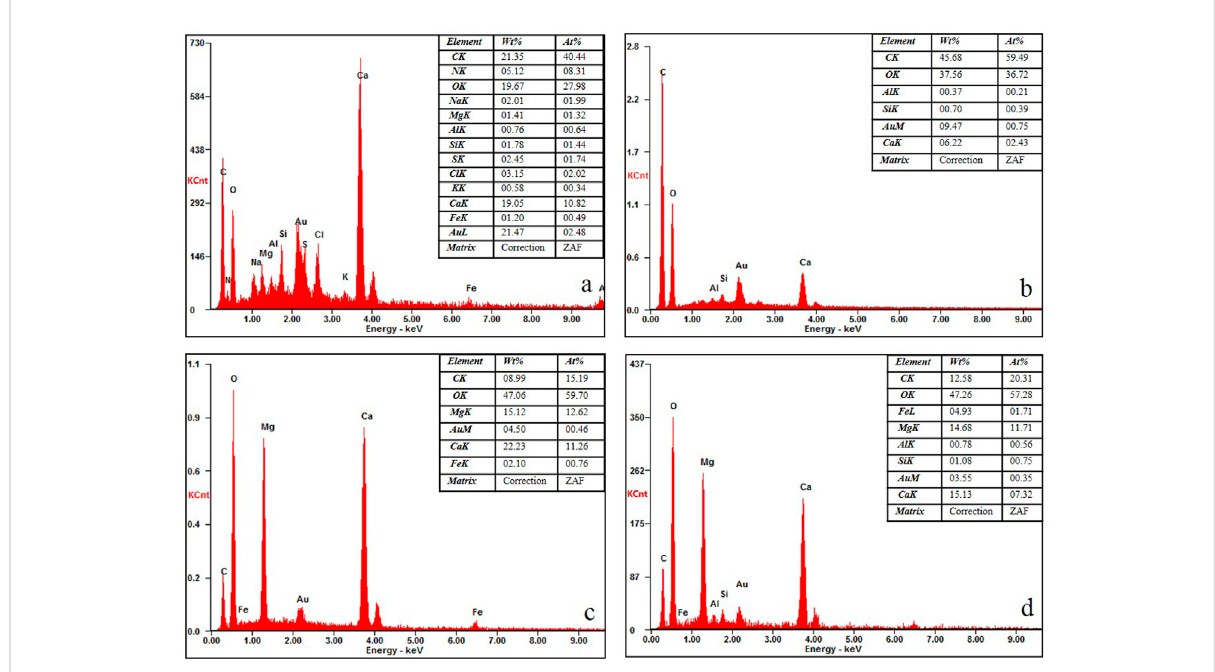
FIGURE 3 CharacteristicsoftheenergyspectrumofthesolidbitumenintheCambrianreservoirs. (A) ∈ 2 z,4720.1 m,wellLT1.Theenergyspectrumshows thatitmainlyincludedC,O,Ca,andN.AhighercontentofCatomsoccurredprimarilyduetotheinterferenceofthebackground(e.g.,solidreservoir bitumen); (B) ∈ 2 x,YJoutcropinShanxiprovince,withtheenergyspectrumindicatingthebitumen; (C) ∈ 2 z,ZYoutcropinShanxiprovince.Theenergy spectrumshowsthatitincludedO, Mg,Ca,andC.HighercontentsofMgandCaatomsindicatethat thebitumenhadoccurredindolomite; (D) ∈ 1 s, 3982.0 m, well L1, with the energy spectrum indicating bitumen.